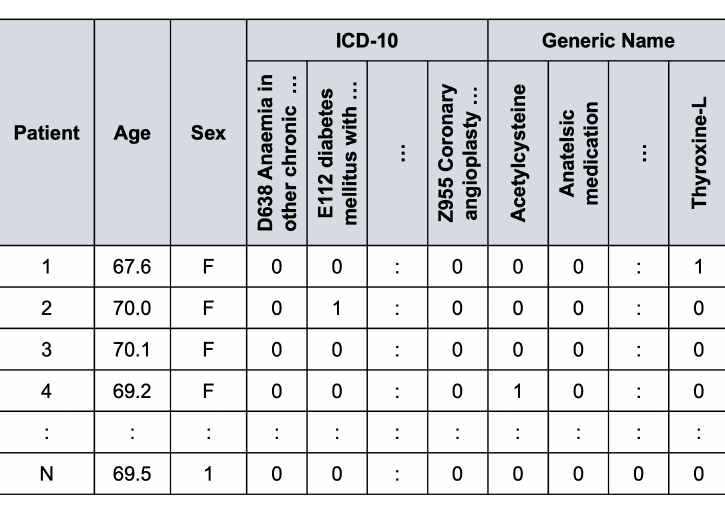
Figure 3. Medications are grouped according to their therapeutic function. Different drugs may belong to the same group.